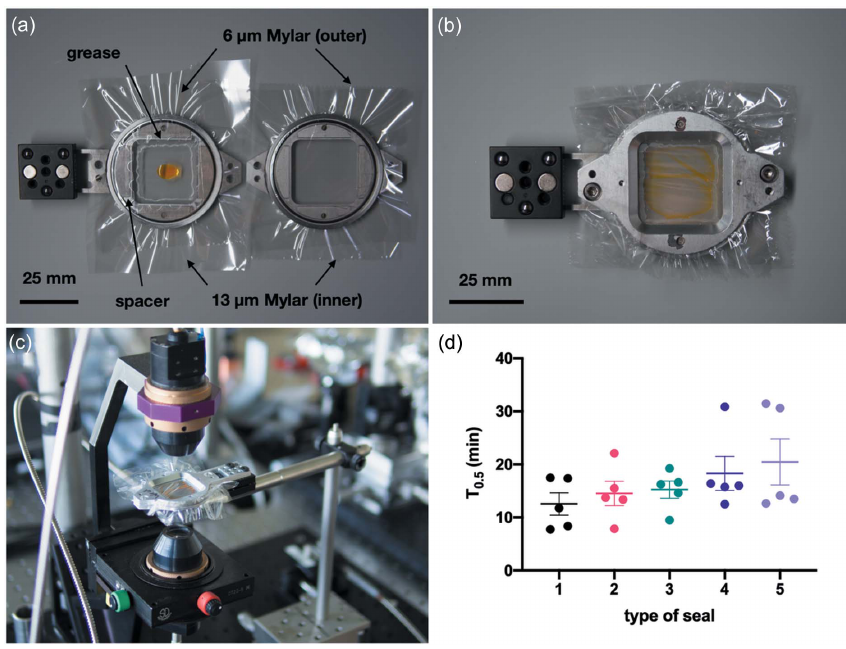
Figure 2 Overview on the ‘sheet-on-sheet’ setup and results from the fluorescence measurements. ( a )–( c ) show how the film sandwiches were prepared and the fluorescence recorded using a micro-spectrometer. This particular case shown used a 3.4 (cid:6) 3.4 cm spacer with vacuum grease and two pieces of 6 and 13 m m Mylar. ( d ) Fluorescent half-lives manifested with the five different types of seal: (1) 2.5 (cid:6) 2.5 cm spacer + 13 m m Mylar, (2) grease + 13 m m Mylar, (3) 2.5 (cid:6) 2.5 cm spacer + grease + 13 m m Mylar, (4) 3.4 (cid:6) 3.4 cm spacer + 13 m m Mylar, and (5) 3.4 (cid:6) 3.4 cm spacer + grease + 13 and 6 m m Mylar. Single measurements are shown as full circles. Mean values and the standard deviations are represented by bars and whiskers,